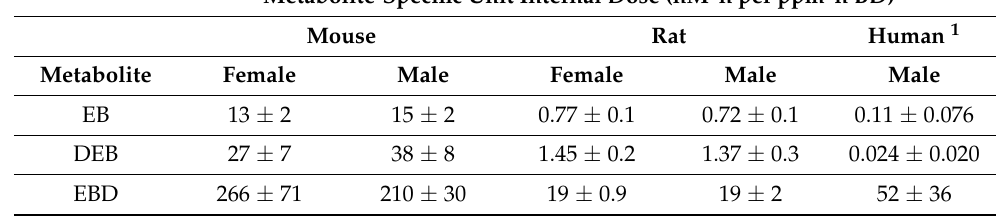
Table 4. Use of hemoglobin adduct data in mice, rats, and humans to quantify species differences in internal dose of BD epoxide metabolites (adapted from Motwani and Tornqvist